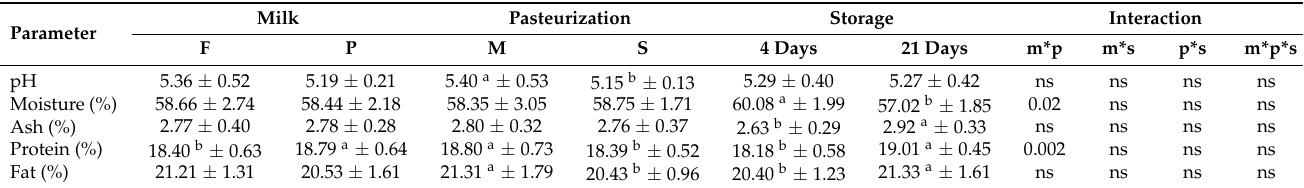
Table 1. Estimated least square means of physico-chemical characteristics of the cheeses considering three fixed factors with two levels each: type of milk (F and P), pasteurization level (M and S), and cheese storage (4 days and 21 days), also considering their interactions. F: fresh milk; P: pre-treated milk; M: minimal pasteurization; S: strong